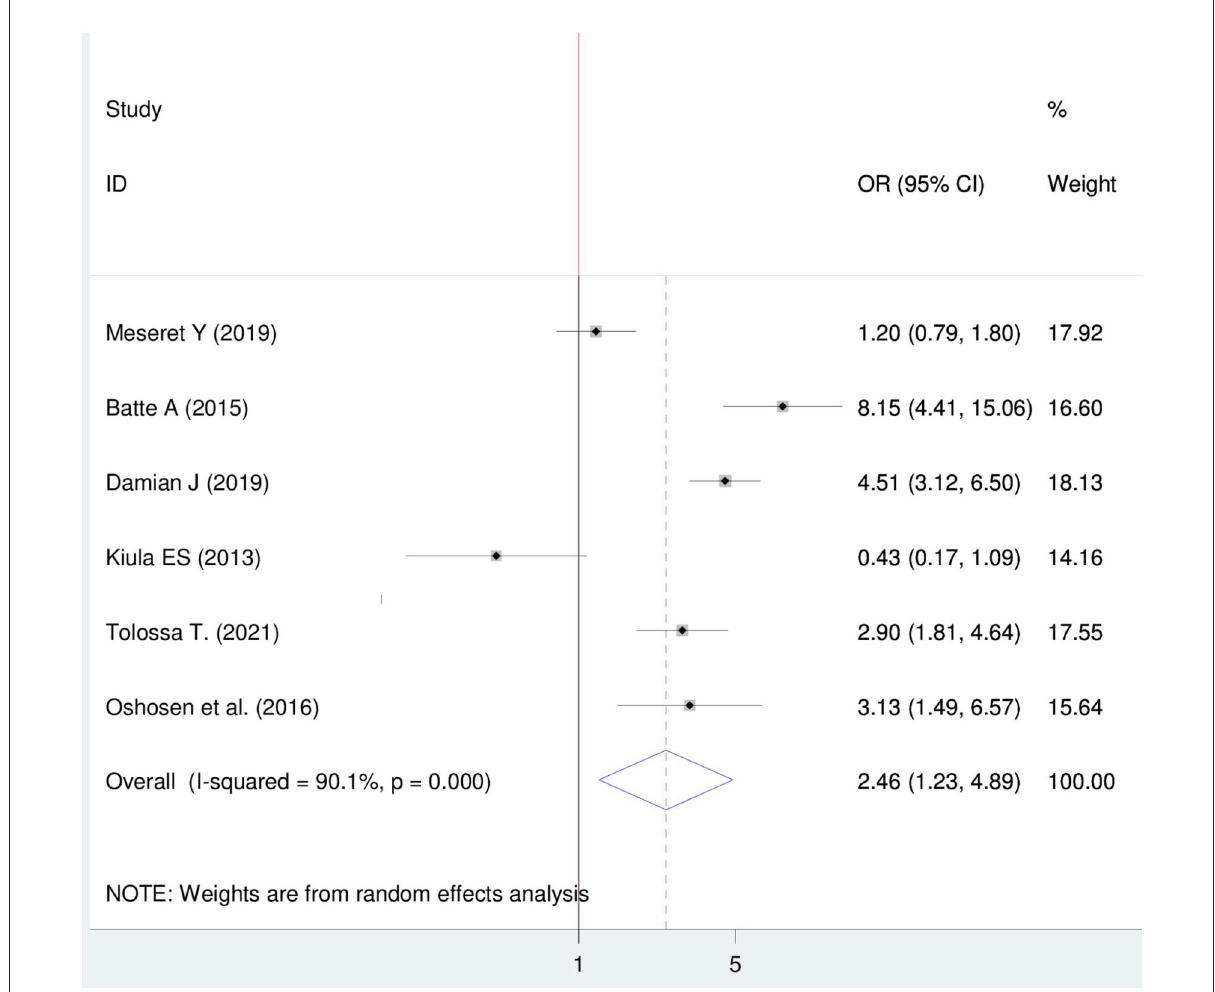
FIGURE7 Forest plot of association between HIV sero-status disclosure and marital status, among women in East Africa